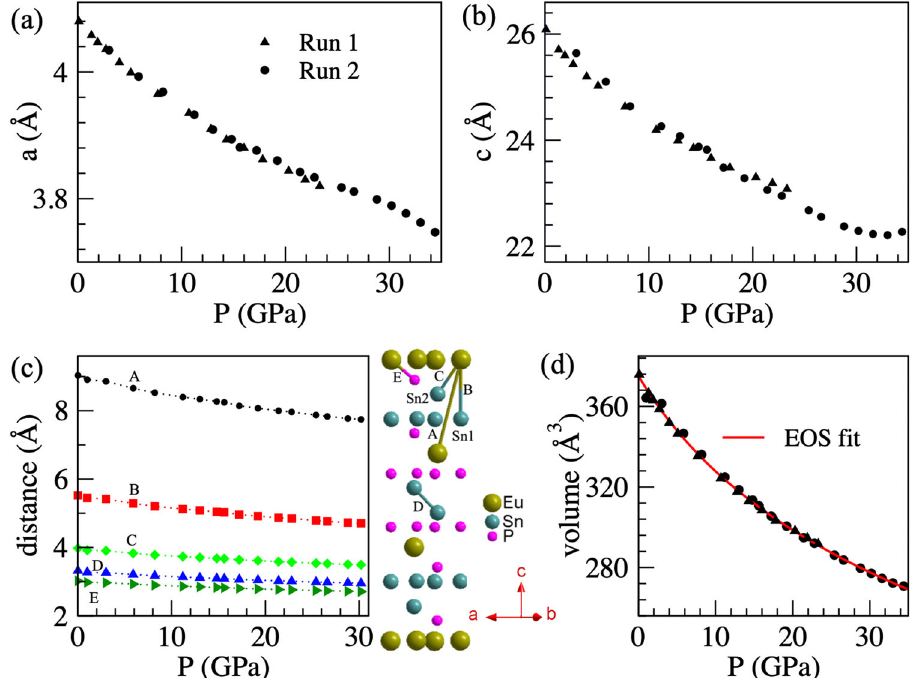
Fig. 2 Evolution of lattice parameters under pressure. Lattice parameters ( a , b ),atomic distances ( c ), and volume and equation of state (EOS) fi t ( d ) of EuSn 2 P 2 under